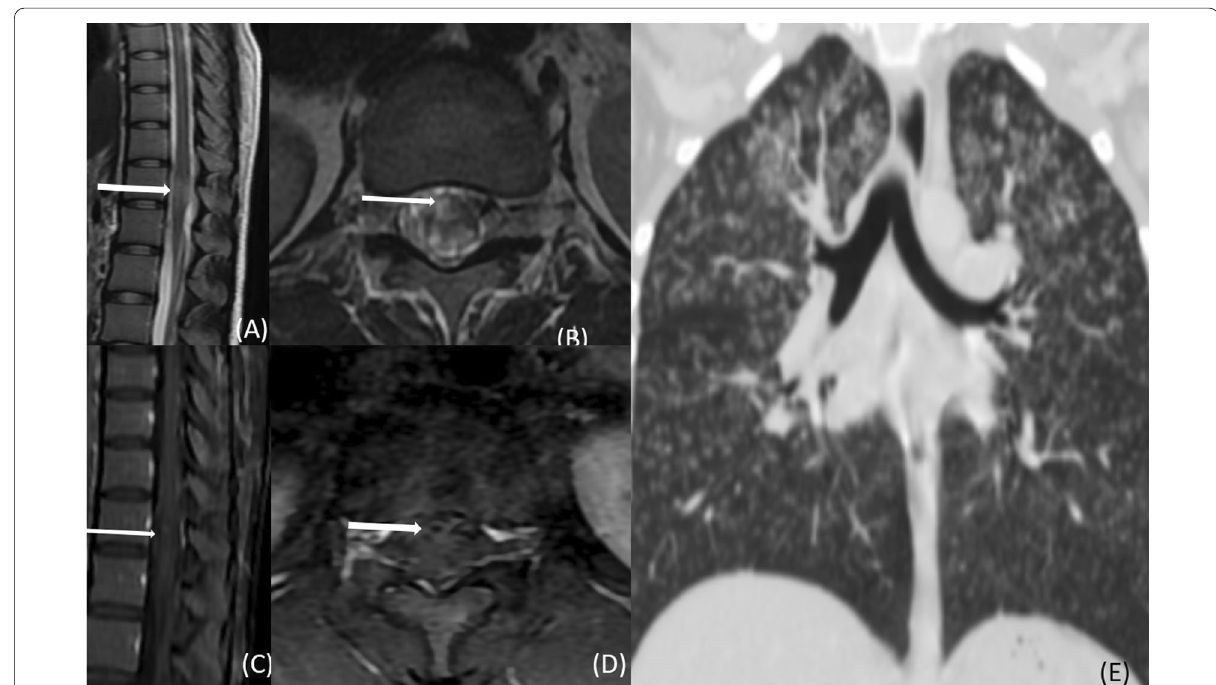
Fig. 4 Intramedullary tubercular granuloma. MRI of a 46-year-old male shows focal ill-defined hyperintensity in cord with cord expansion at T12 vertebral level on sagittal T2W image (arrow in A ), axial T2W image shows cord expansion with ill-defined hyperintense lesions in the cord (white arrow in B ), T1W contrast-enhanced sagittal image shows subtle enhancement (arrow in C ) and axial image shows ring enhancement (arrow in D ), chest CT shows miliary tubercular nodules in both lungs ( E